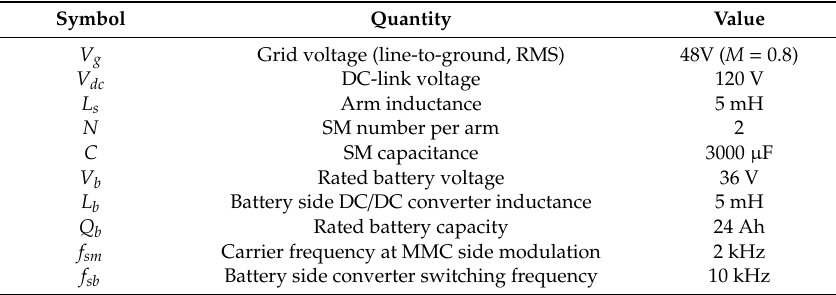
Table 2. Main parameters of the prototype.